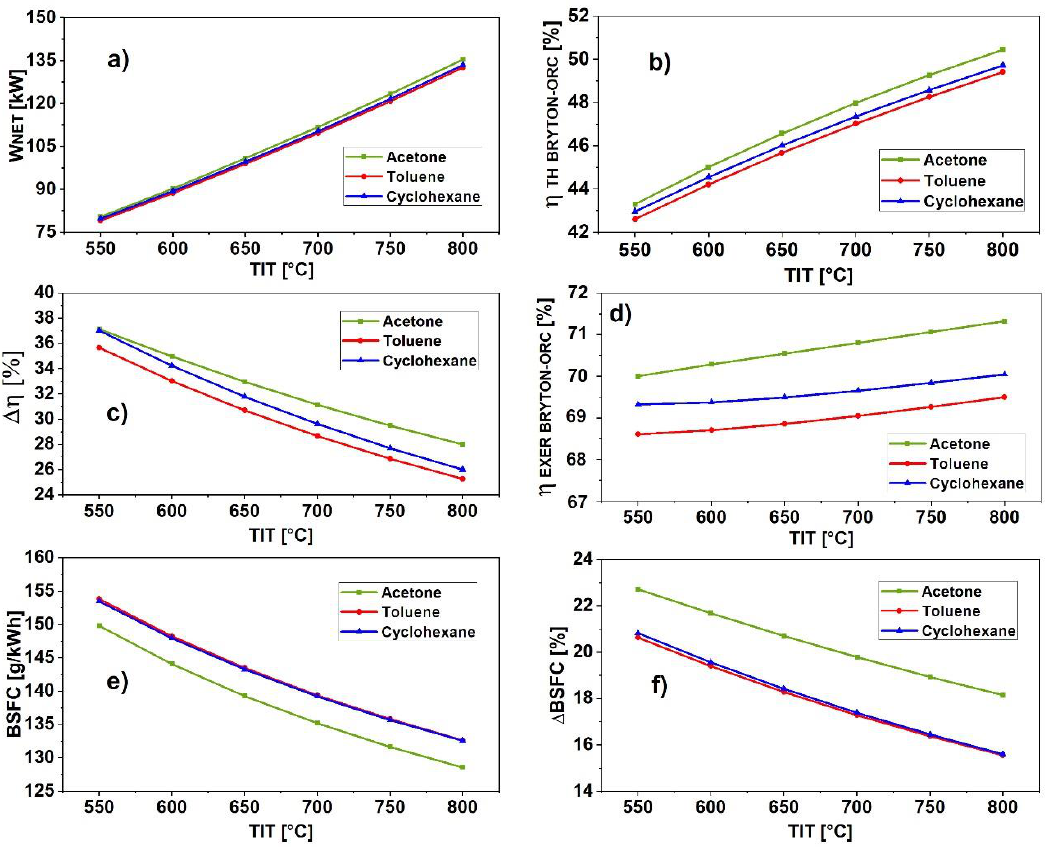
Figure 5. System performance parameters with respect to TIT, ( a ) net power; ( b ) thermal efficiency Brayton-ORC; ( c ) absolute increase in thermal efficiency; ( d ) exergy efficiency Brayton-ORC; ( e ) brake-specific fuel consumption; ( f ) absolute decrease in brake-specific fuel consumption.